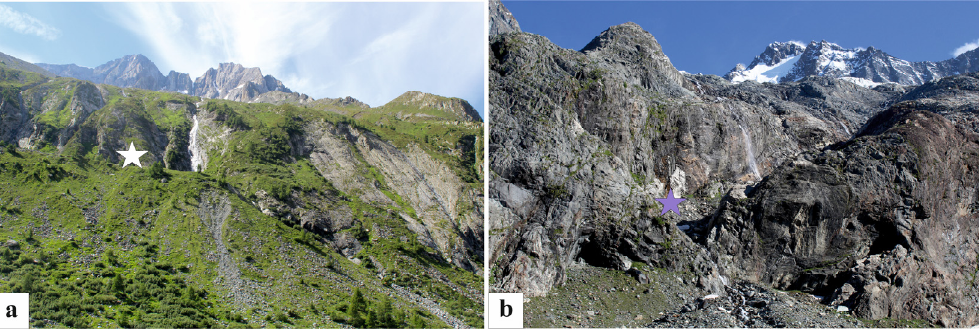
Figure 5. ( a ) Overviews of the left side ( a ) and right side ( b ) of the Sissone valley, with the locations of the investigated samples (stars).